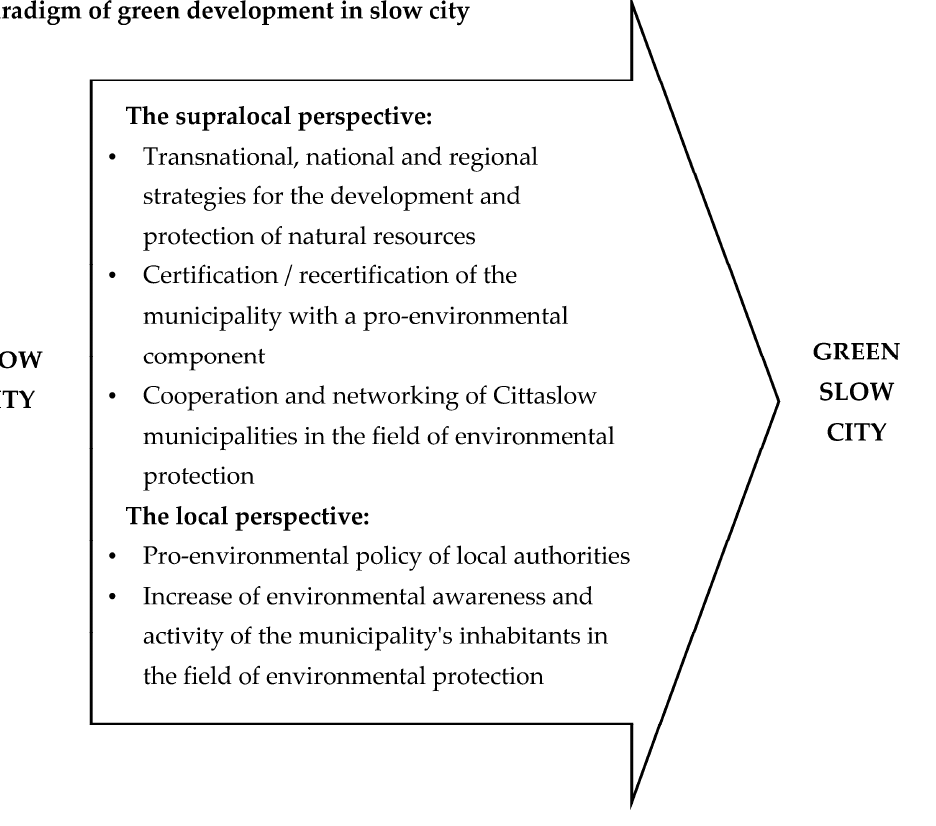
Figure 1. Evolution of the slow city into the green slow city. Source: own elaboration.